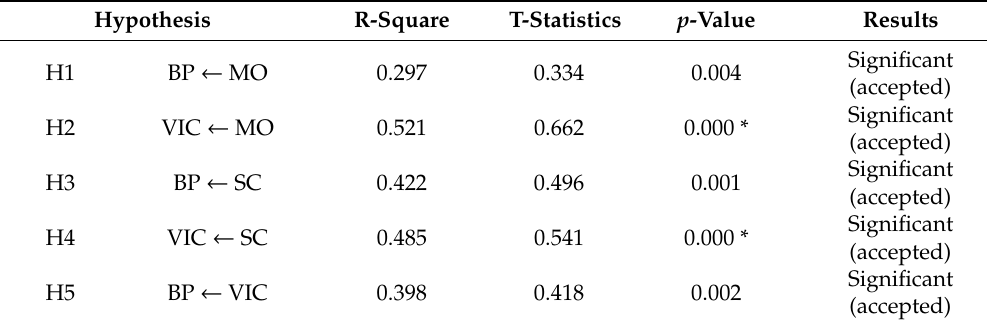
Table 4. Hypothesis